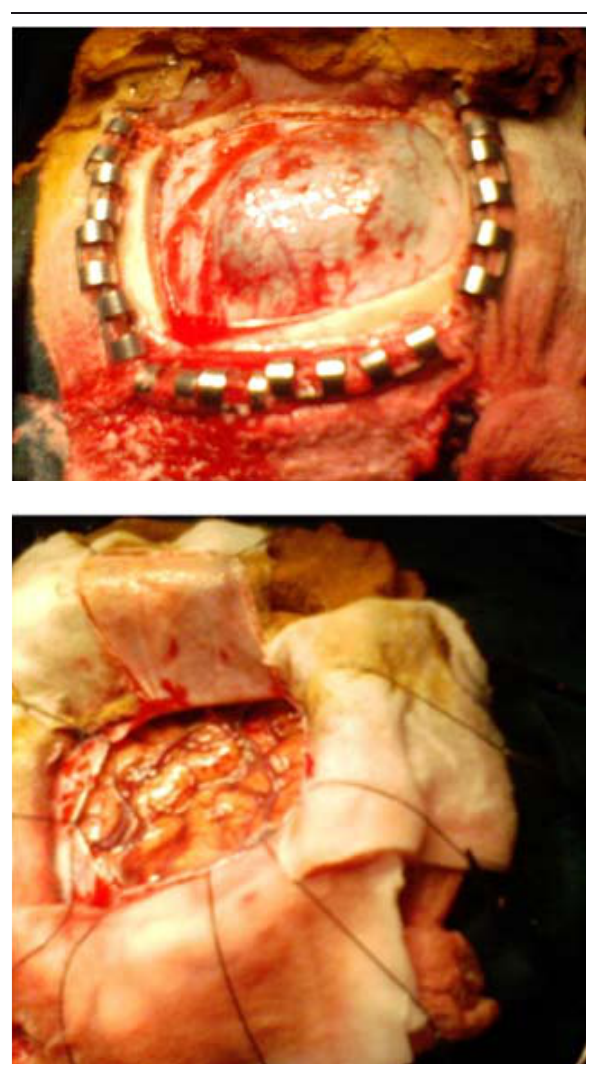
Figure 3. Intraop picture showing the cyst before (3A) and after marsupilisation (3b)